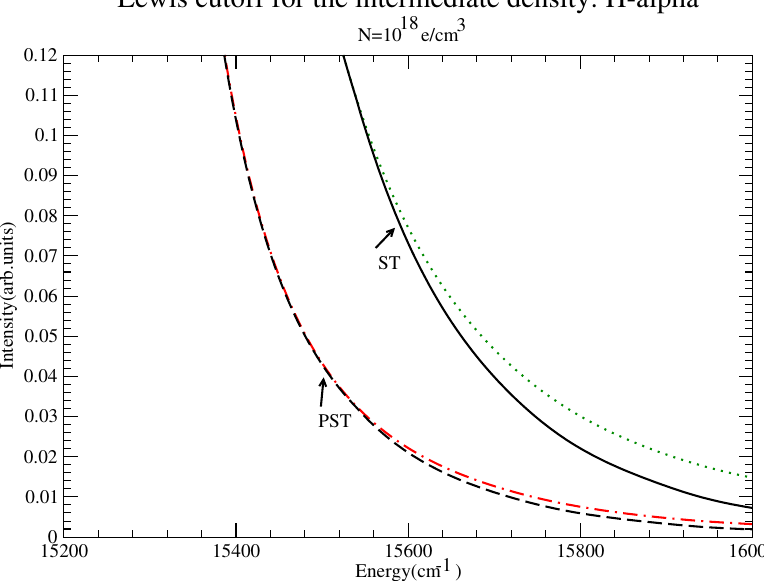
Figure 6. H α for CONVST and CONVPST with and without the Lewis cutoff for the intermediate density. Shown are CONVST with Lewis cutoff (black solid), CONVST without Lewis cutoff (green dotted), CONVPST with Lewis cutoff (black dashed) and CONVPST without Lewis cutoff (red dash-dotted).